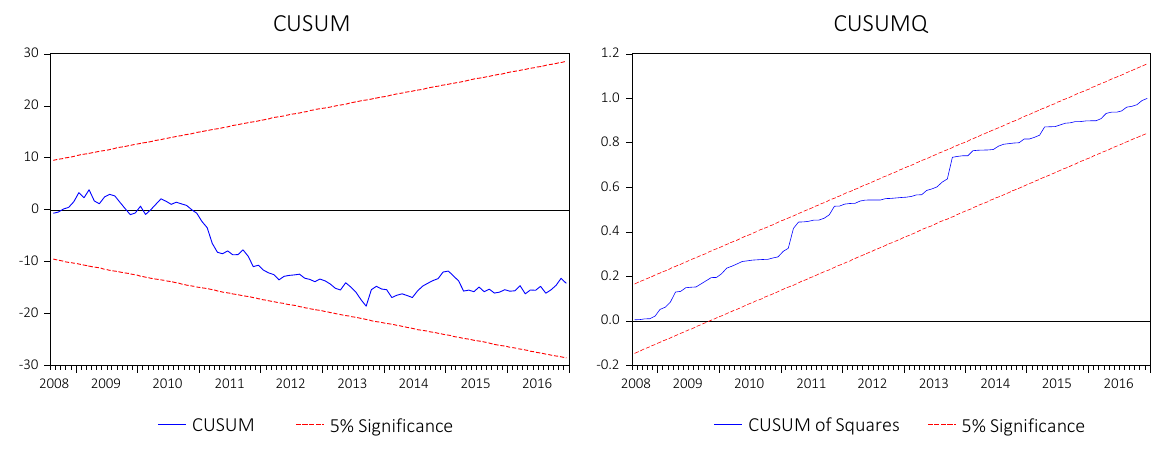
Figure 2. CUSUM and CUSUMQ (2007–2016)